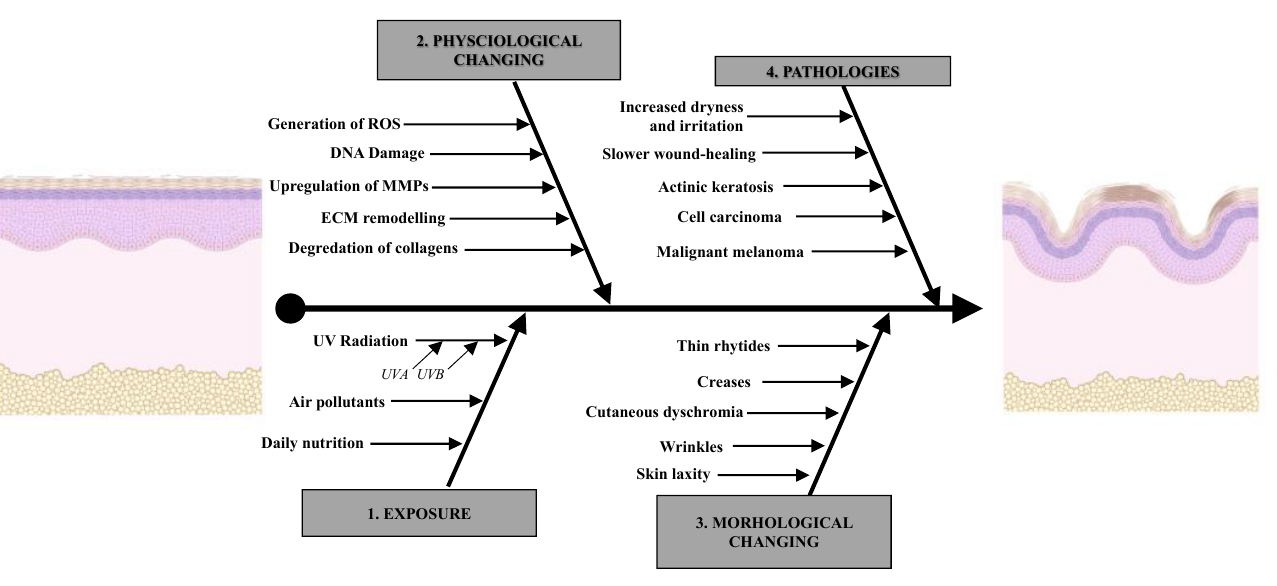
Figure 2. Aging in younger to older skin (Adapted from “skin epithelium”, by BioRender [29]).